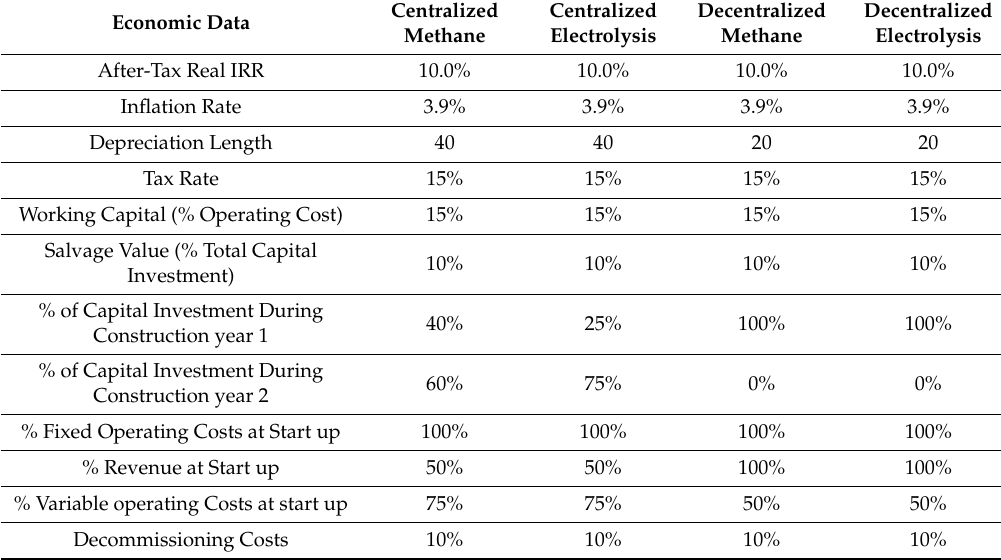
Table A3. Economic data for performing cash flow study.